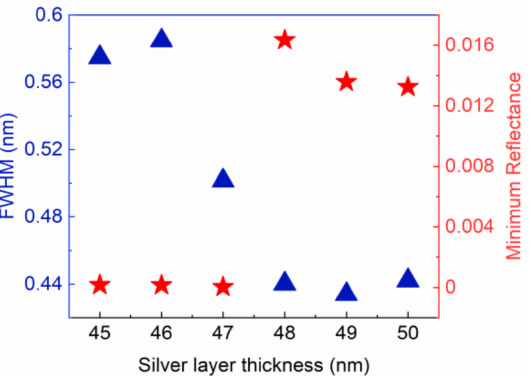
Figure 4. Optimal thicknesses of gold layers on silver layers with different thicknesses and corre- sponding R min (pentagram) and FWHM